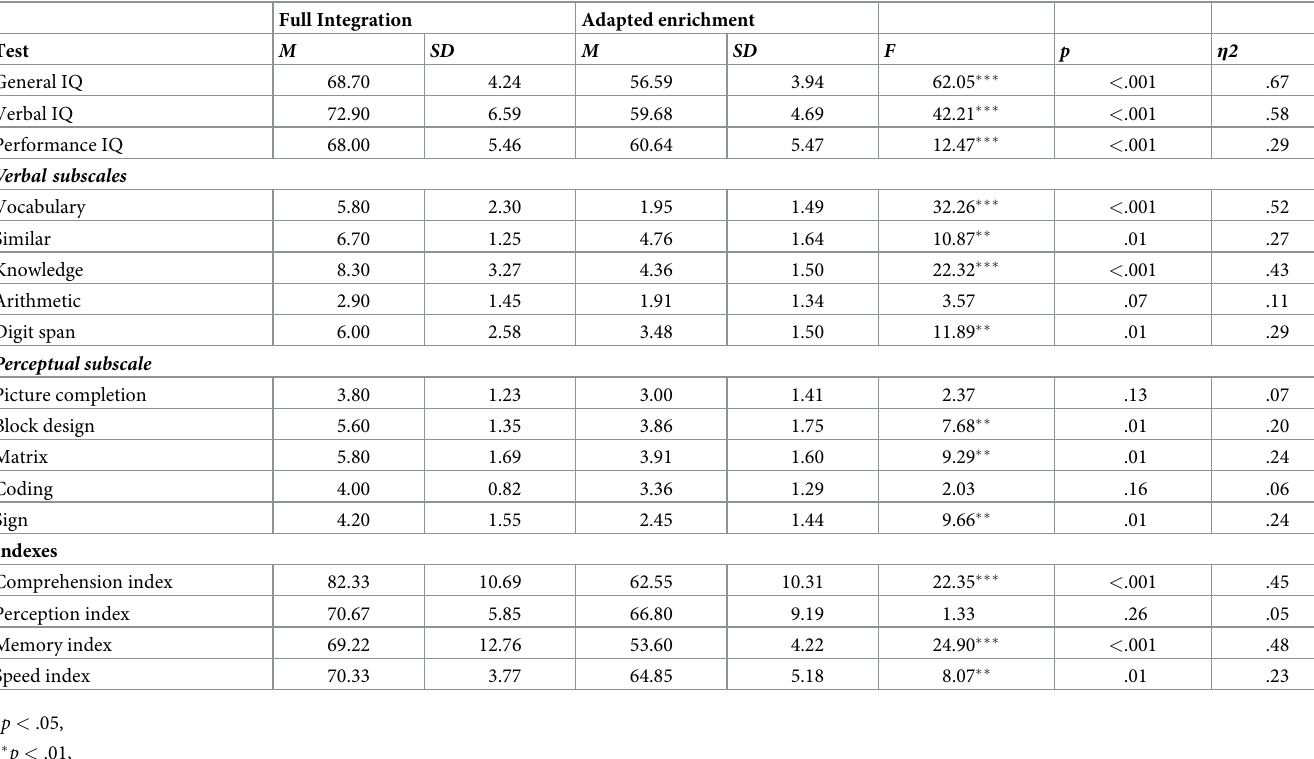
Table 2. Mean, SD, and F values of the WAIS IQ tests in the full inclusion ( N = 10) and adapted enrichment ( N = 21) groups. Full Integration Adapted